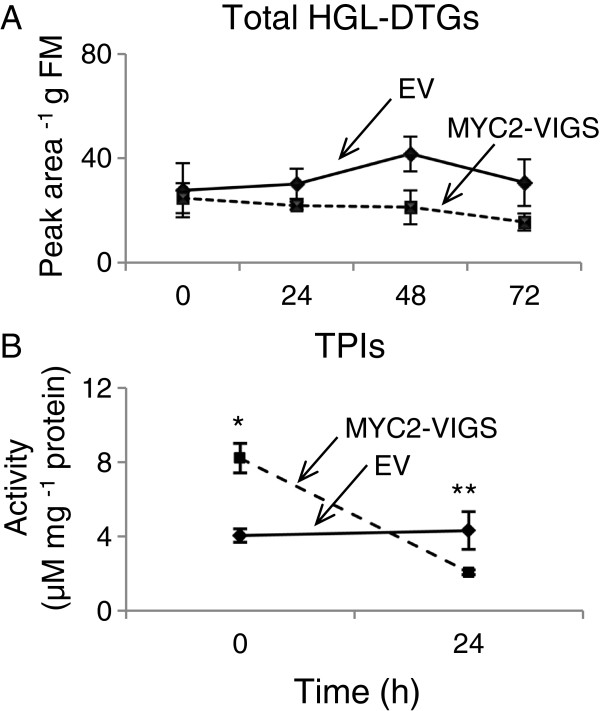
WOS-induced accumulation of HGL-DTGs and TPI activity in EV and MYC2-VIGS plants. Leaves (n=5) of EV- and MYC2-VIGS plants were treated with WOS for 24 h, 48 h or 72 h or left untreated (0 h) and collected to extract and analyze accumulation (mean ± SE) of total HGL-DTGs (A) on HPLC-PDA. Using un-induced (0 h) and WOS-induced (24 h) samples from the same experiment, TPI activity (B) was determined using a radial diffusion assay. Asterisks indicate significant statistical differences.